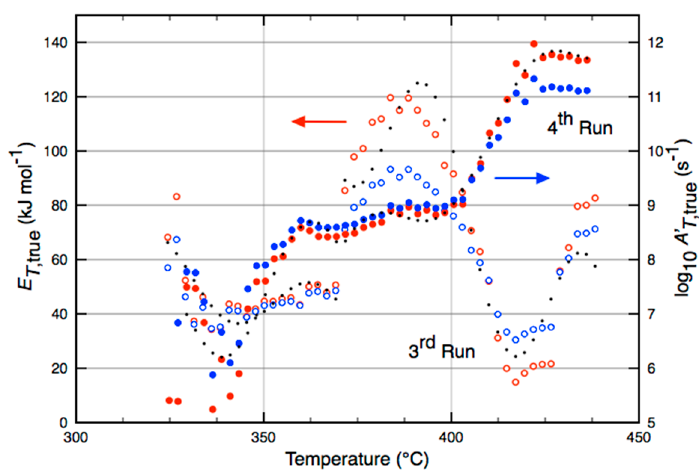
A (cid:48) (blue circles) (cid:1827) (cid:3021),(cid:2930)(cid:2928)(cid:2931)(cid:2915)(cid:4593) (blue circles) T ,true 10 10